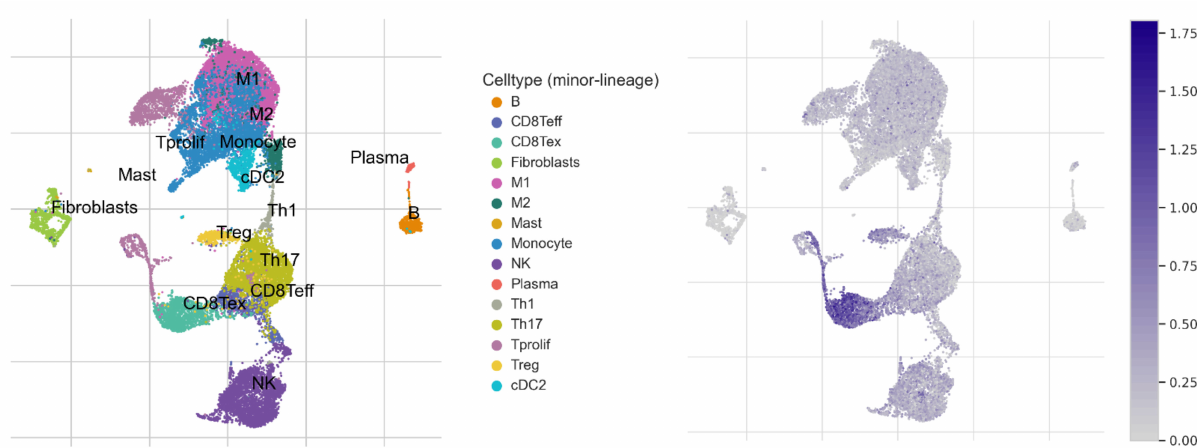
Figure 10. The expression source of the signature genes was revealed by single-cell analysis (GSE111360 dataset). The signature was composed of GOT2 , LAG3 , CTLA4 , EOMES , LGALS9 , CD96 , HAVCR2 , PDCD1 , TIGIT , and TOX .